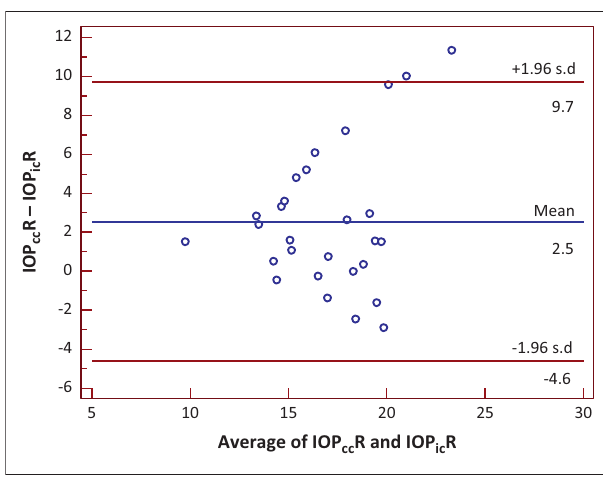
FIGURE 1: A Bland-Altman plot for IOP between the two IOP measures is 2.55 mmHg.